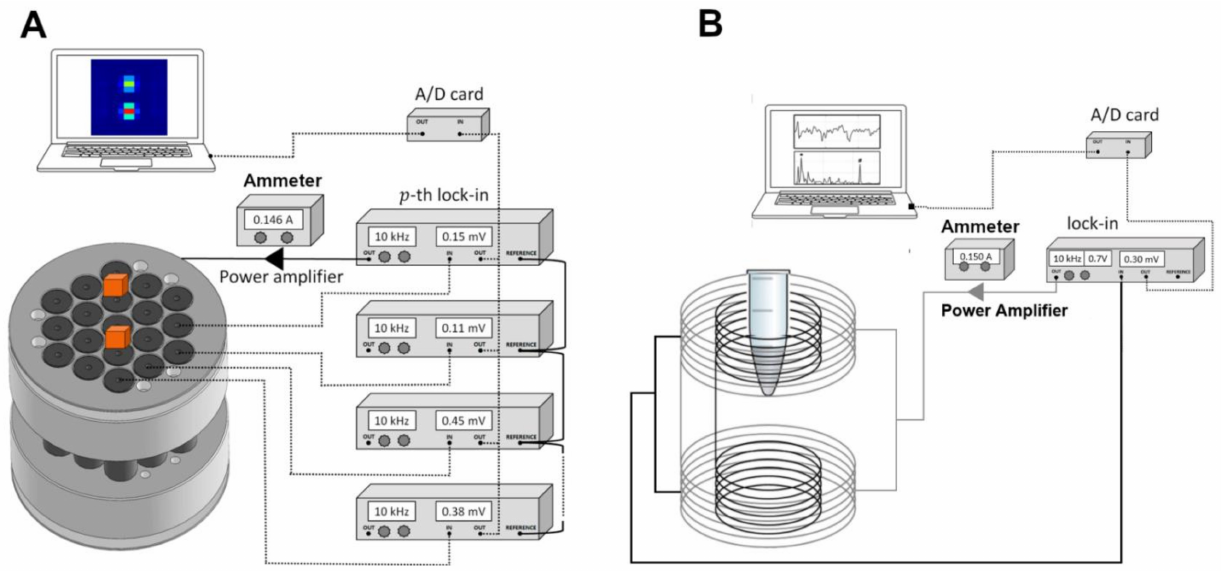
Figure 1. Schematic representation of both ABC setups utilized. ( A ) MC-ACB and ( B ) cavity ACB